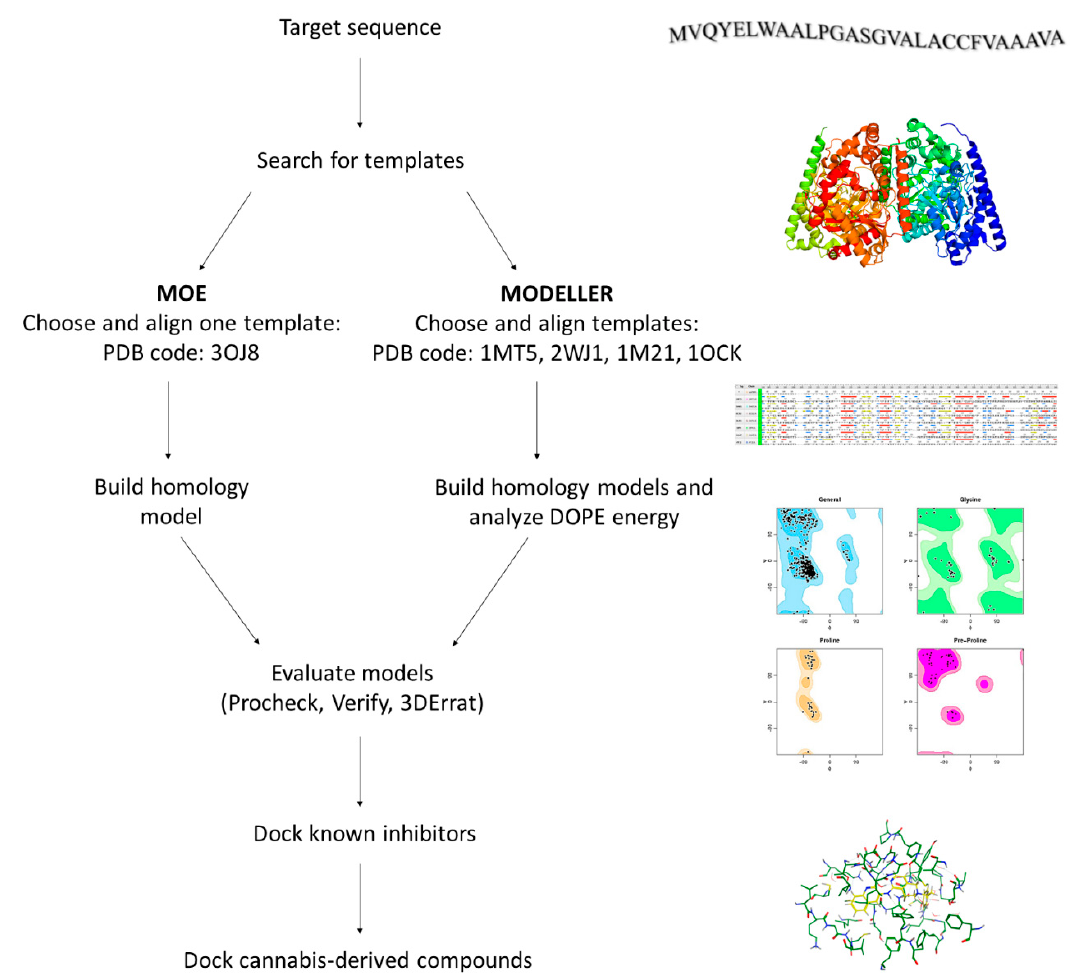
Figure 3. Flowchart of the homology modeling approach used to build the 3D structure of